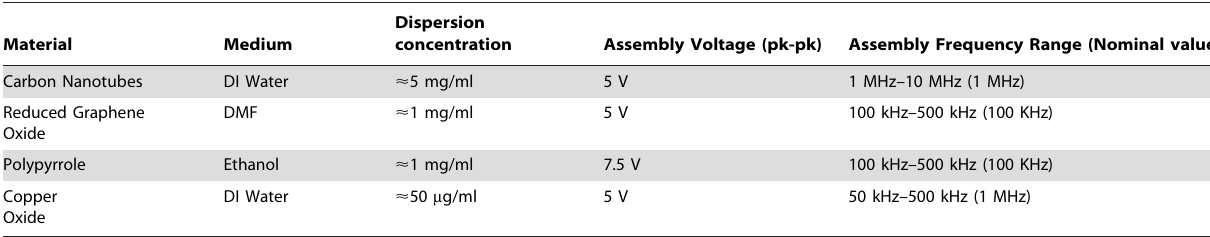
Table 1. Optimum DEP assembly parameters.